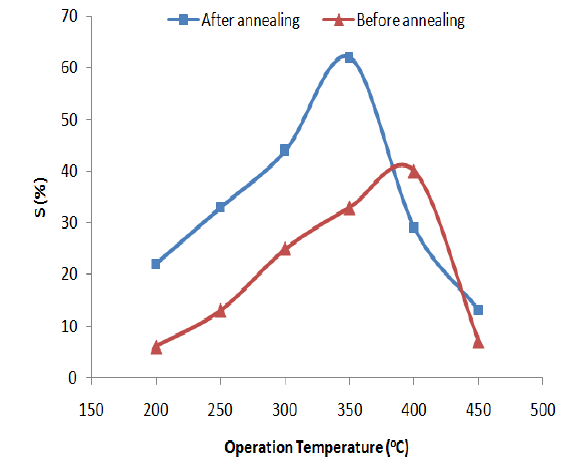
Fig. 5: The sensor sens i tivity as a function of operation temperature (H fixed at 100 ppm).